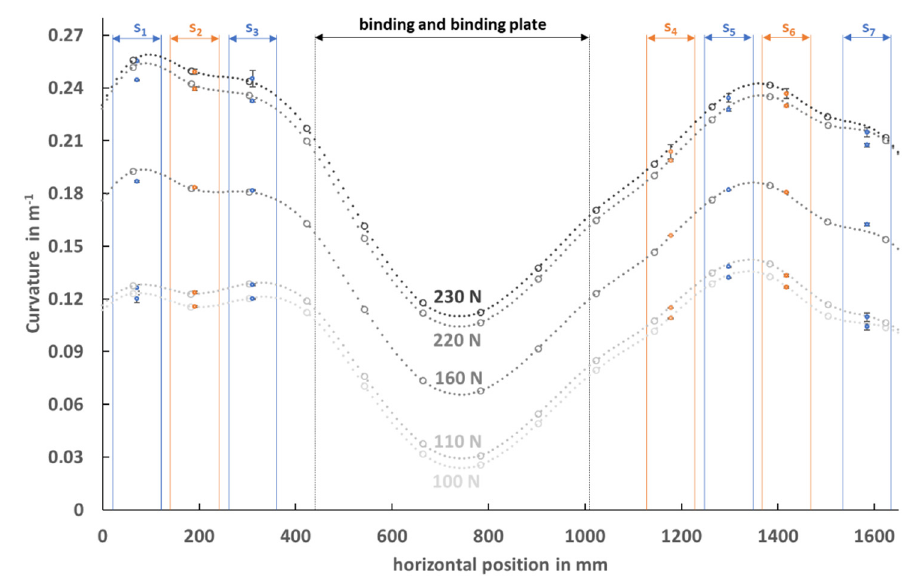
Figure 6. The orange and blue data points represent the calculated mean curvature from the PyzoFlex ® data (mean ± SD) of the middle sensor row for the corresponding segments (S 1 to S 7 ). The large gray data points represent the curvature progression calculated from the laser data at different load levels (100 N, 110 N, 160 N, 220 N and 230 N). The interpolated points (small gray data dots) were used for the numerical calculation of the mean segmental curvature. Note: There are no sensors in the binding area, and for the sake of completeness, the data from the laser measurement system are displayed.